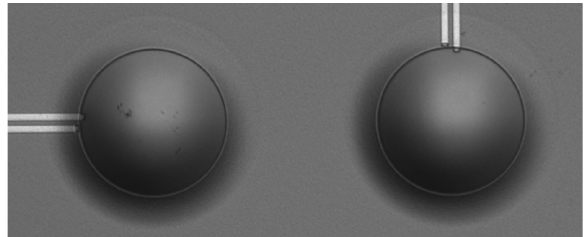
Figure 2. Optical microscope image of two piezoelectric micromachined ultrasonic transducers